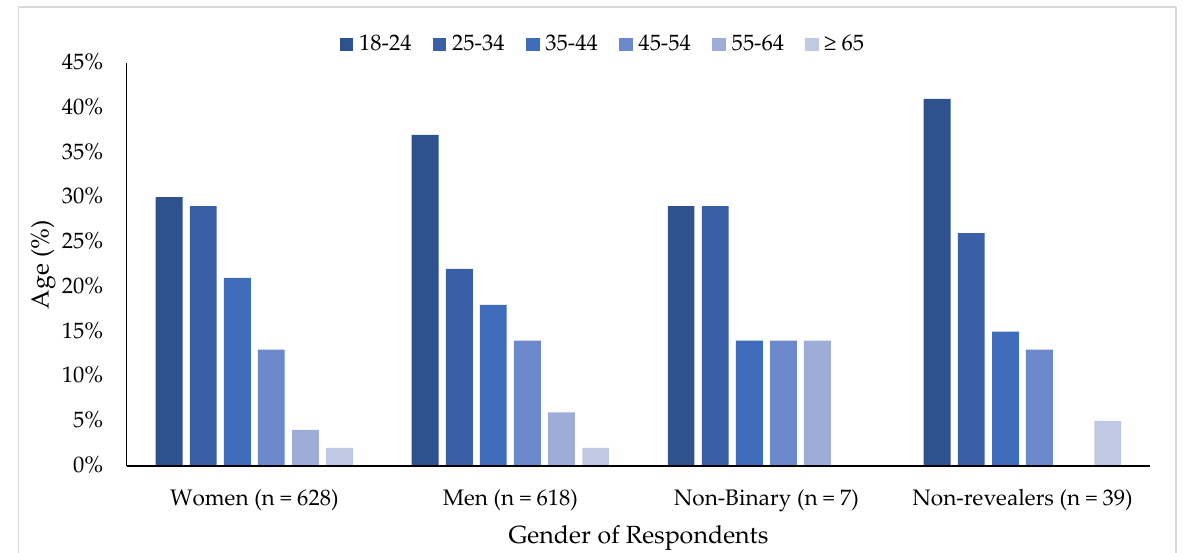
Figure 1. Percentage of respondents in each age category within self-identified gender groups (n = 1301).